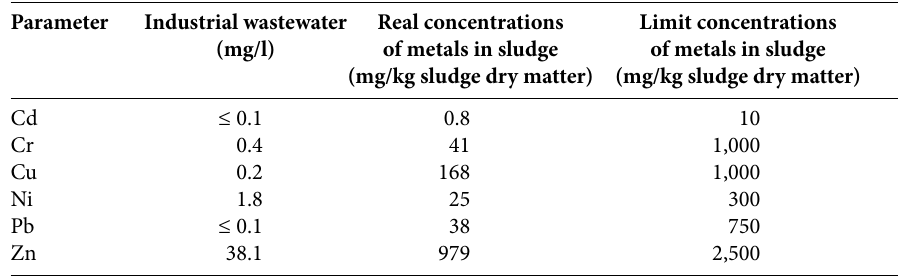
Table 2. The concentrations of heavy metals in industrial wastewater, real concentrations of metals in sludge from Slovak WWTP 41 , and limit concentrations of metals in sludge from WWTP applied to soil. 38